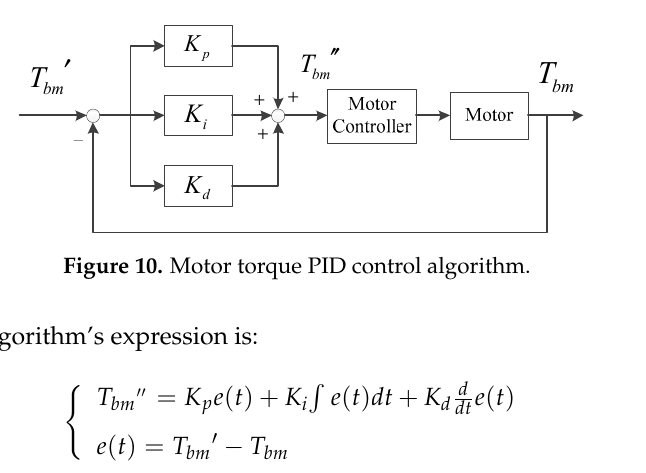
Figure 9. Flow control chart of the second type mode-switch.